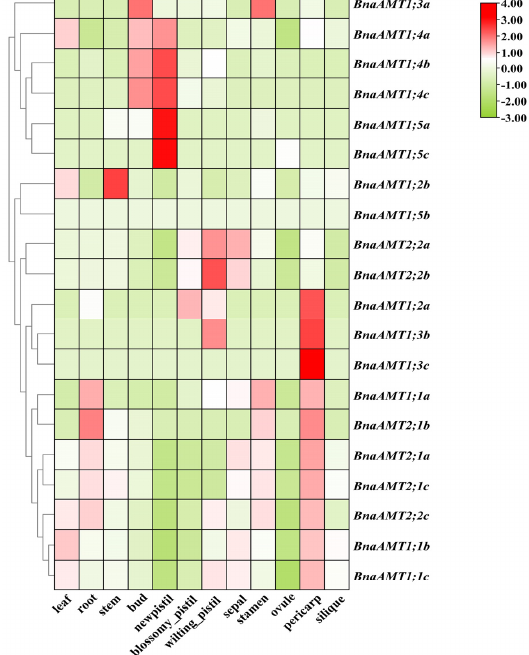
Figure 3. Tissue-specific expression profiles of BnaAMT family genes. Heat maps of BnaAMT expression were generated from RNA-seq analysis in twelve different tissues, including leaves, roots, stems, buds, new pistils, blossomy pistils, wilting pistils, sepals, stamens, ovules, pericarps, and siliques. The red color indicates upregulation, while the green color indicates downregulation. 3.4. Expression of BnaAMT Genes in Response to N Deficiency and Resupply